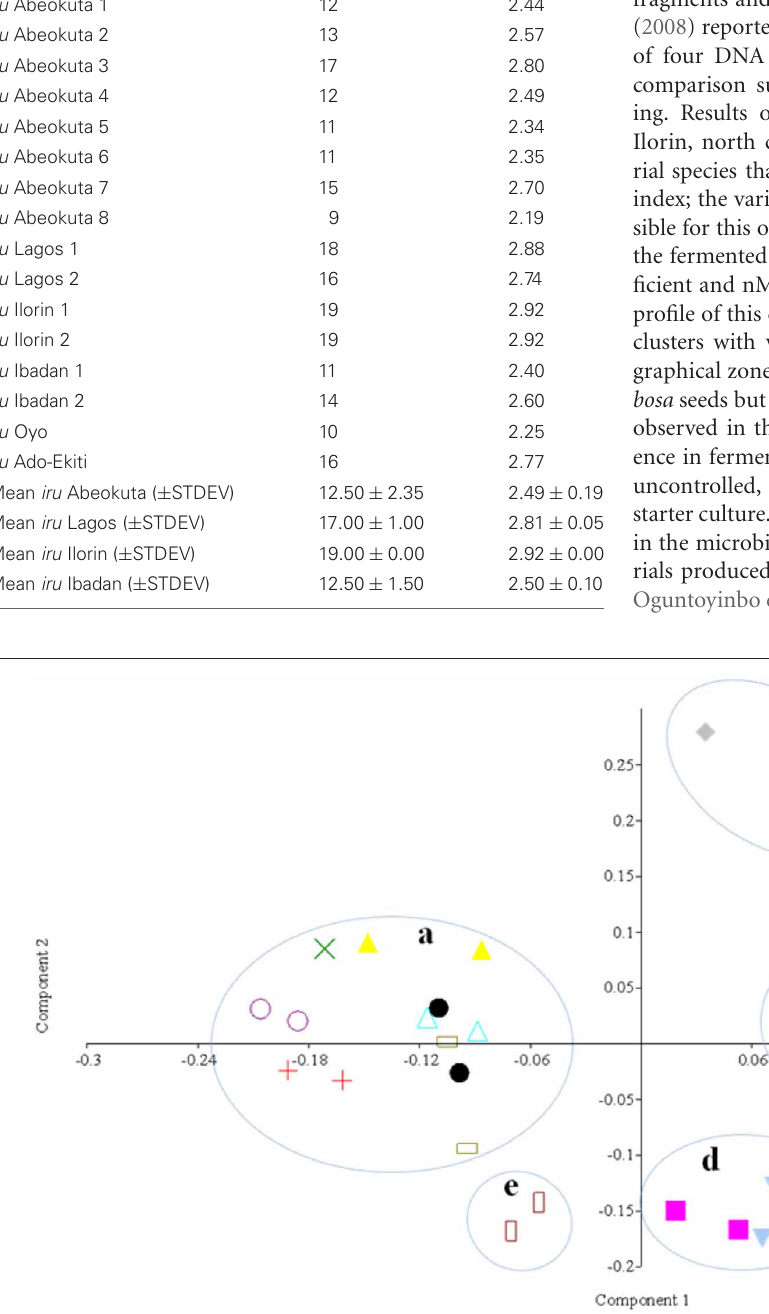
FIGURE 1 | Non-metric Multidimensional Scaling analysis of DGGE data Group (a): iru Abeokuta 2 southwest Nigeria ( + ); iru Abeokuta 3 southwest Nigeria ( (cid:2) ); iru Lagos 1 southwest Nigeria ( (cid:2) ); iru Lagos 2 southwest Nigeria ( • ); iru Ilorin 1 northcentral Nigeria ( (cid:3) ) ; iru Ilori n 2 northcentral Nigeria ( ); iru Ibadan 1 southwest Nigeria ( ).